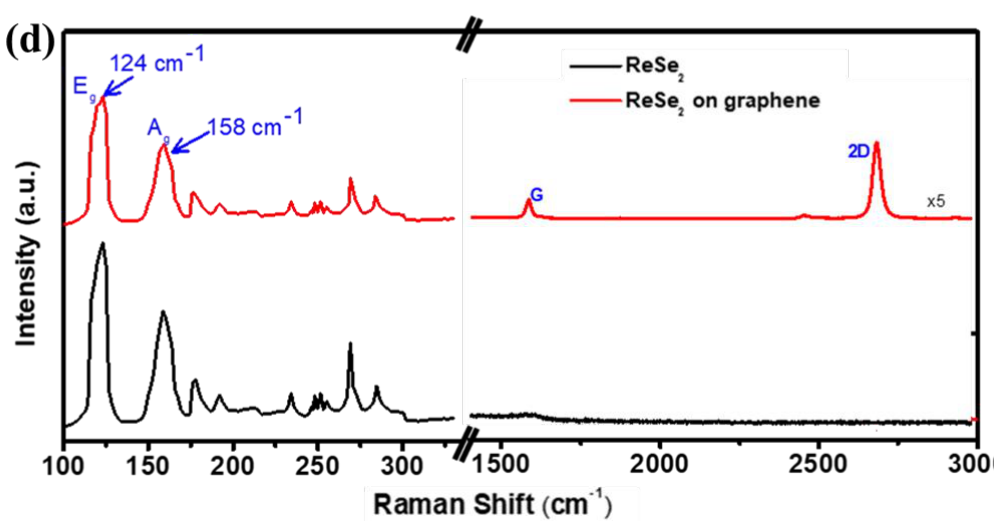
Figure 1. ( a ) Schematic illustration and ( b ) real device optical image of graphene/ReSe 2 van der Waals heterostructure (scale bar; 5 µm), ( c ) SEM micrograph (scale bar; 5 µm), whereas yellow dotted line indicate graphene layer. ( d ) Raman analysis of ReSe 2 (black curve) and graphene/ReSe 2 heterostructure (red curve).